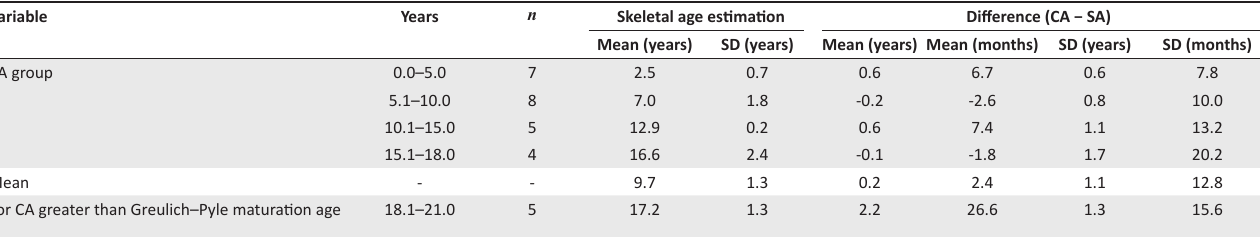
TABLE 3: Group analysis of difference between the skeletal age and chronological age for Reader 1 for various ages in female patients only ( N = 24). Variable